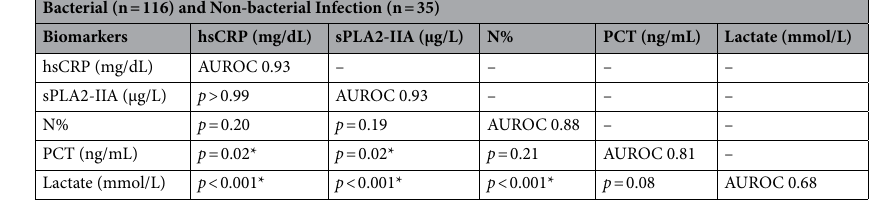
Table 4. Comparison of the performance of biomarkers’ AUROC to differentiate bacterial infection in ED. AUROC area under receiver operating characteristic curve (0.70–0.79 = Fair, 0.80– 0.89 = Good, > 0.90 = Excellence); p p -value, hsCRP high-sensitive C-reactive protein, sPLA2-IIA secretory phospholipase 2-IIA, N% neutrophil percentage, PCT procalcitonin.* p < 0.05 indicates a significant difference between the two biomarkers of interest.